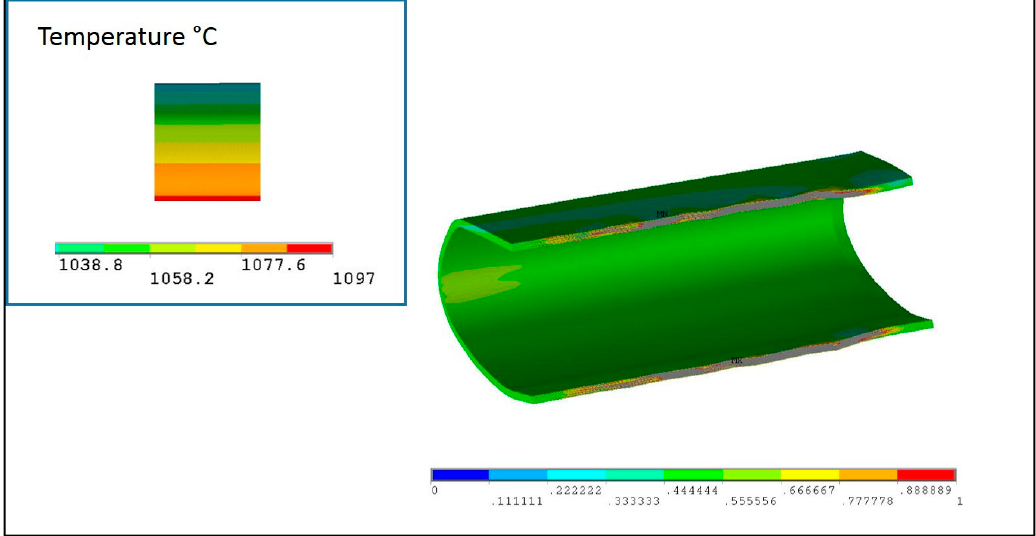
Figure 14. maximum failure indexes at 1200 seconds - Full model. Figure 14. Maximum failure indexes at 1200 s - Full